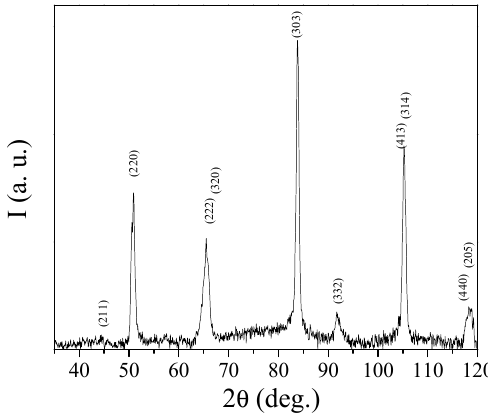
Figure 44. X-ray diffraction pattern of as-prepared Ni 63.8 Mn 11.1 Ga 25.1 sample. Reproduced from reference [128], Figure 1.